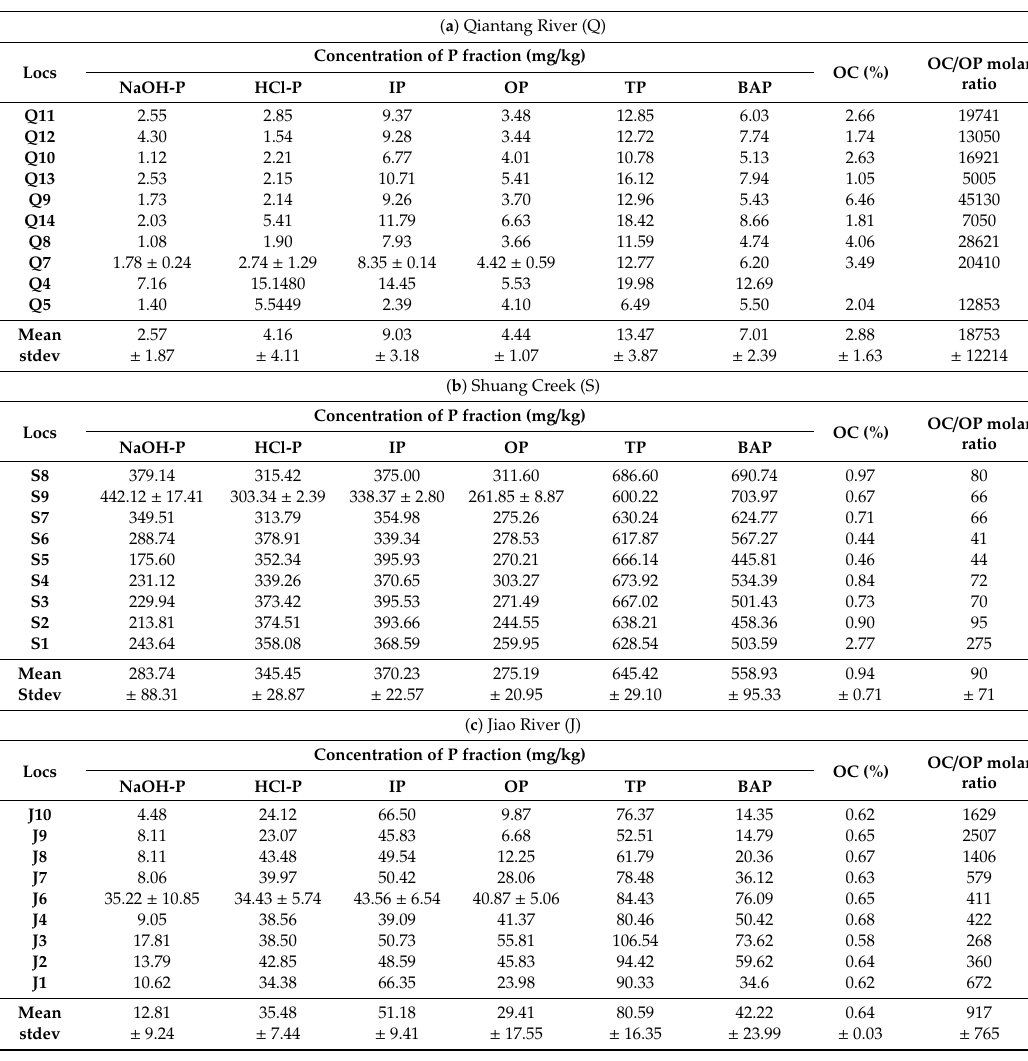
Table A4. Sedimentary P fractions in the rivers. ( a ) Qiantang River (Q), ( b ) Shuang Creek (S), ( c )